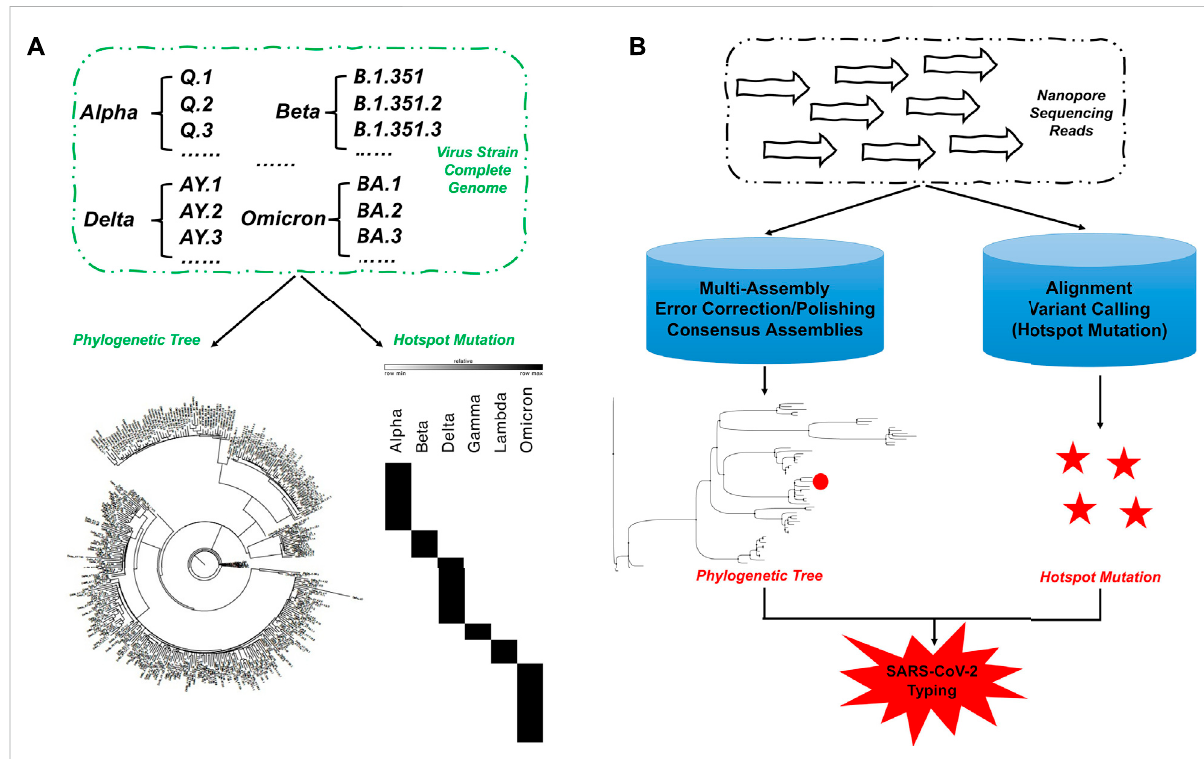
FIGURE 1 SchematicdiagramshowingtheanalyticalprincipleofNanoCoV19. (A) Constructionofareferencesequencesandhotspotmutationsdatabase. (B) Pipeline for lineage analysis of SARS-CoV-2 based on nanopore sequencing